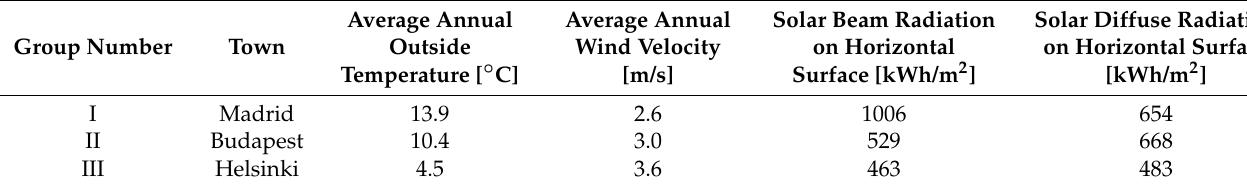
Table 3. List of the main modules of the SDHW system model.